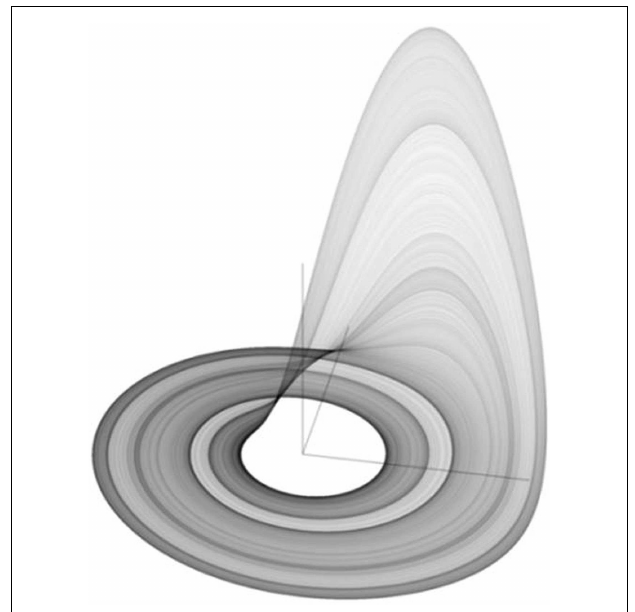
FIGURE 10 |The Rössler strange attractor in its chaotic mode. Public source: